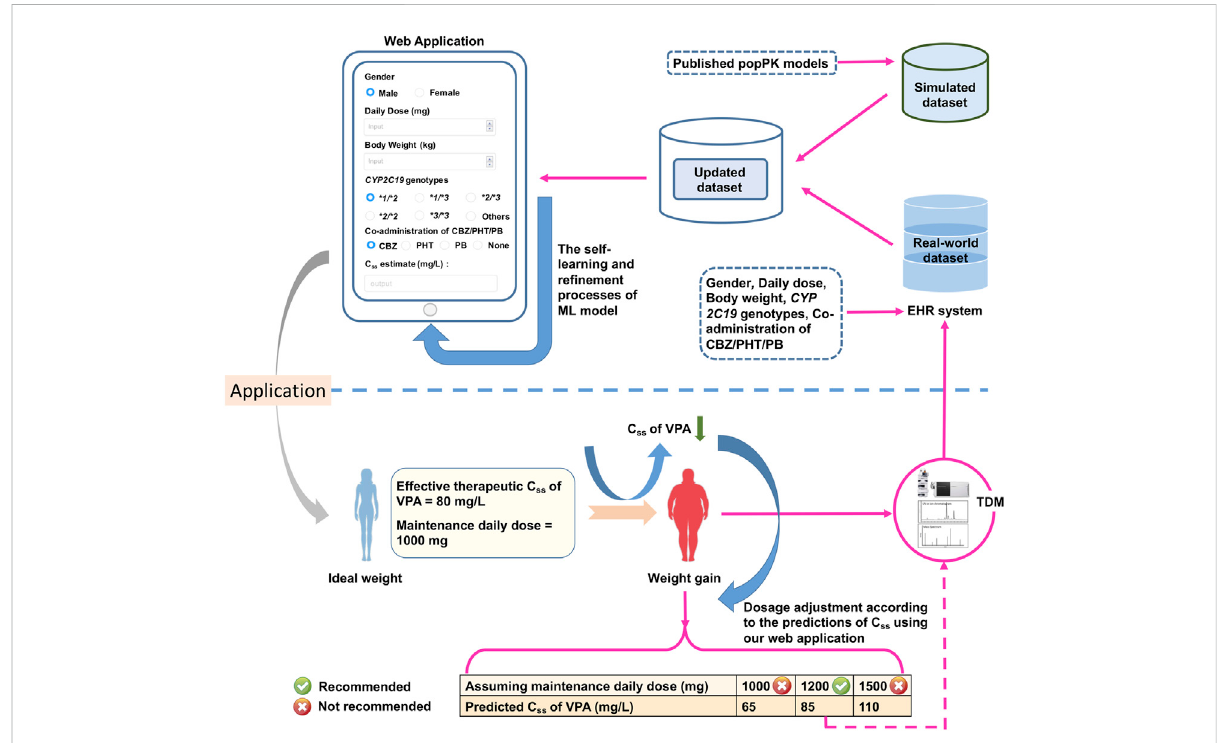
FIGURE 8 The designed web application for real-time estimations of the value of C ss of VPA based on the simpli fi ed optimum XGBoost model. The database can be updated by integrating our simulated dataset with empirical data that are automatically crawled from the electronic health record (EHR) system. This may enhance the self-learning and re fi nement of the ML